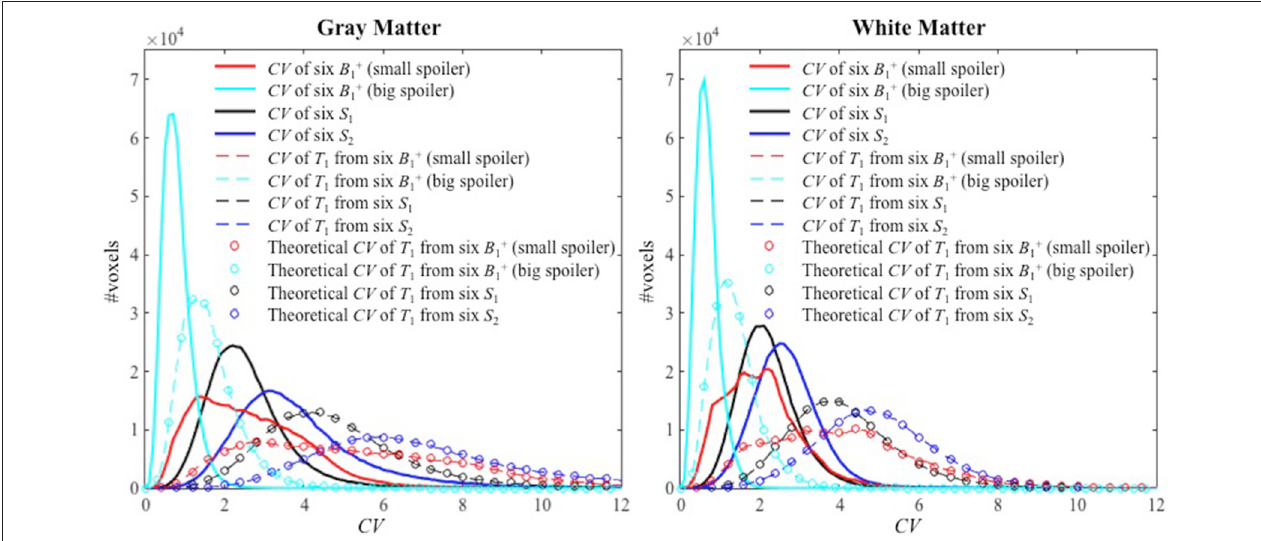
FIGURE 5 | The histograms of CV values for Experiments 1–4 inside GM (left) and WM (right). The solid lines, dashed lines, and circles represent the CV of the six input images, the experimental CV of T 1 calculated from the six input images ( Experimental variance evaluation ), and the theoretically-predicted CV of T 1 ( Theoretical variance evaluation ) respectively. The histograms for Experiments 1–4 are shown with red, cyan, black and blue colors,